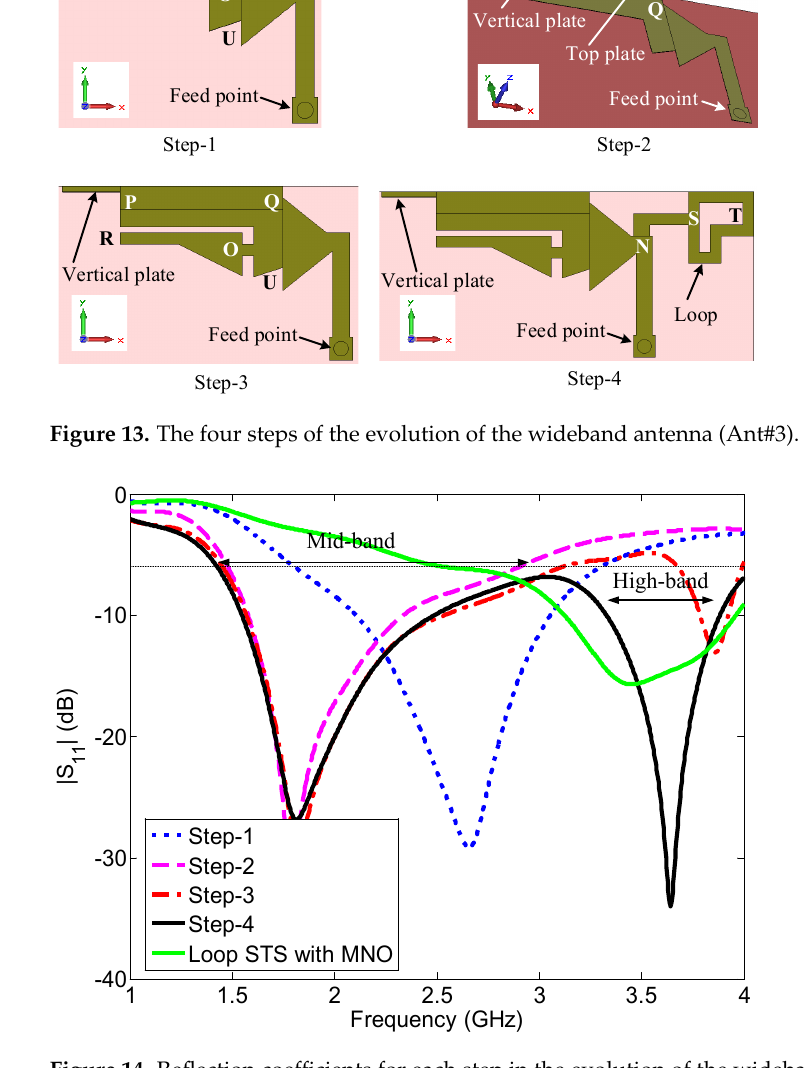
Figure 14. Reflection coefficients for each step in the evolution of the wideband antenna